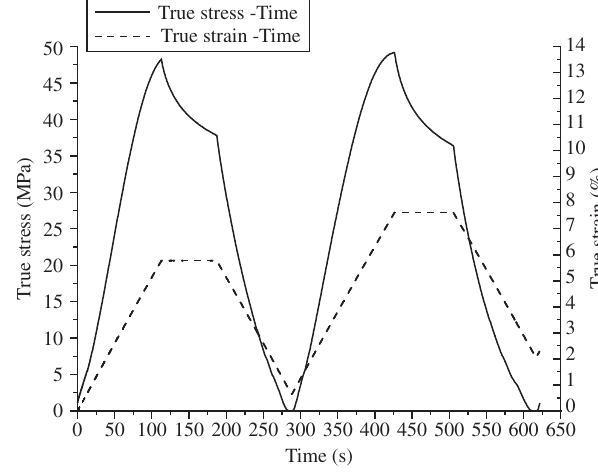
Figure 16. Stress-time and strain-time curves for two